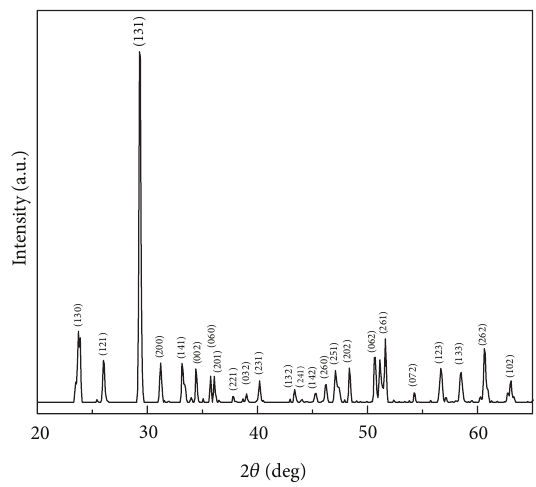
Figure 1: XRD patterns of as-prepared CaNb 2 O 6